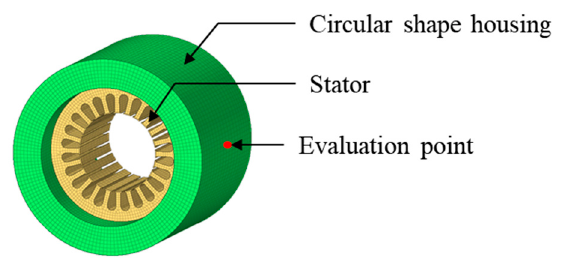
Figure 9. Circular shape housing initial model.